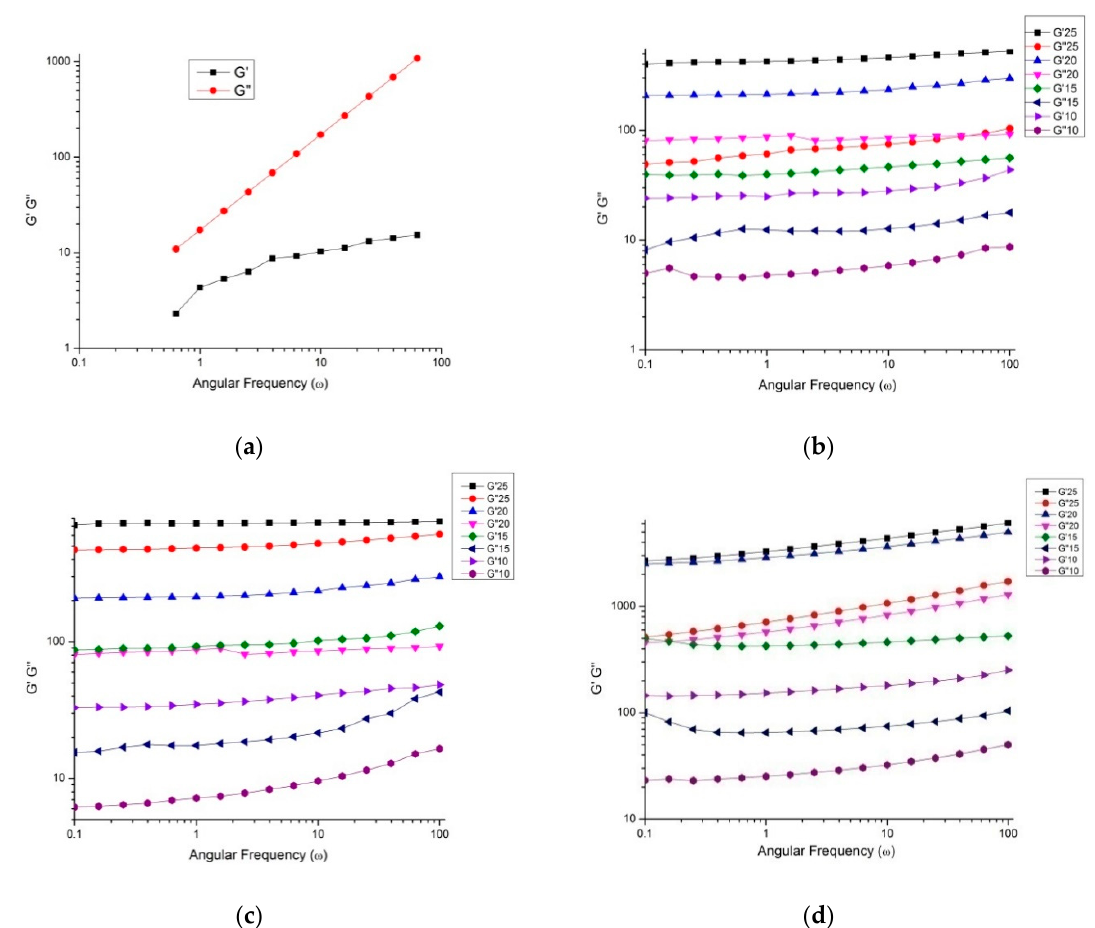
Figure 7. Storage modulus (G ′ ) and loss modulus (G ″ ) as a function of angular frequency ( ω ) for ( a ) honey and nutritionally rich honey powders developed using ( b ) MD, ( c ) gum arabic and ( d ) WPC respectively, at different concentrations.